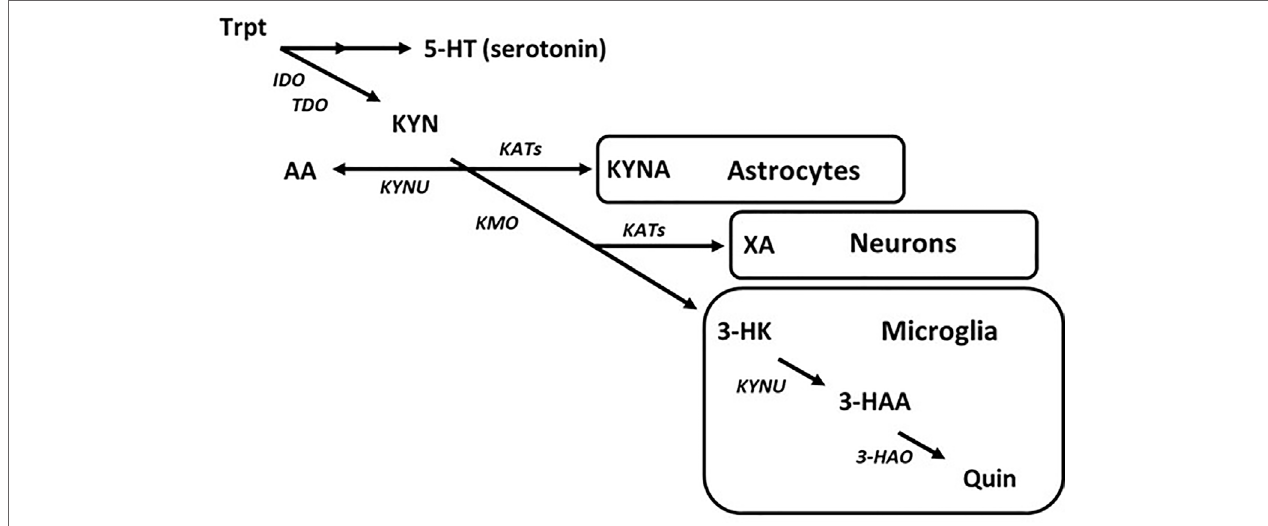
FIGURE 3 | The kynurenine pathway of tryptophan metabolism in the brain. Simplified diagram depicting the tryptophan–kynurenine pathway. Metabolism of tryptophan along the kynurenine pathway in the brain is regulated by a variety of enzymes that are largely segregated by cell